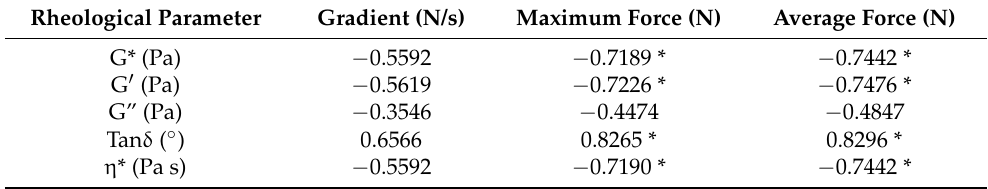
Table 3. Pearson’s correlation coefficient between rheological and extrusion parameters. Rheological Parameter Gradient